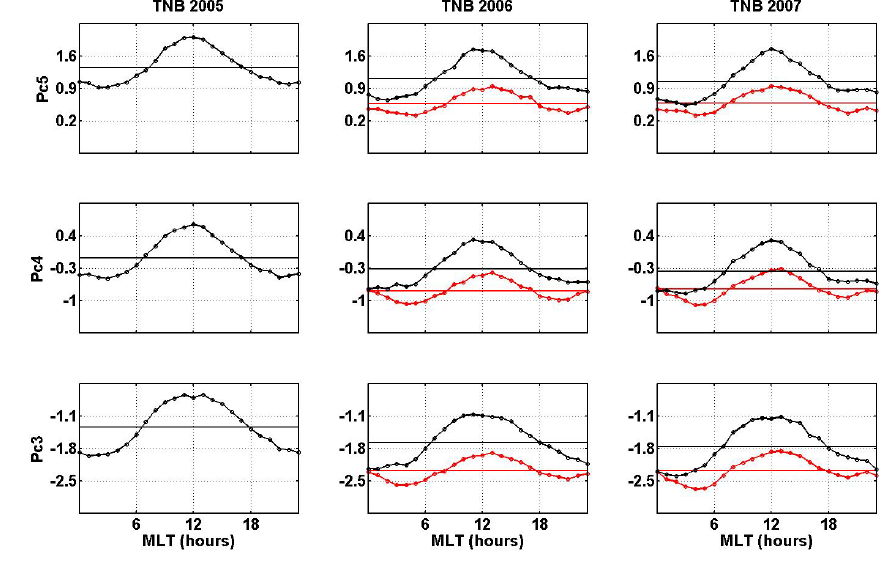
Fig. 4. Same as Fig. 3 at TNB. Table 2. Correlation coefficient ρ between the logarithm of the Pc3, Pc4 and Pc5 power at DMC and TNB and V SW a . 1-day 1-h All Summer Winter All Summer Winter N 348